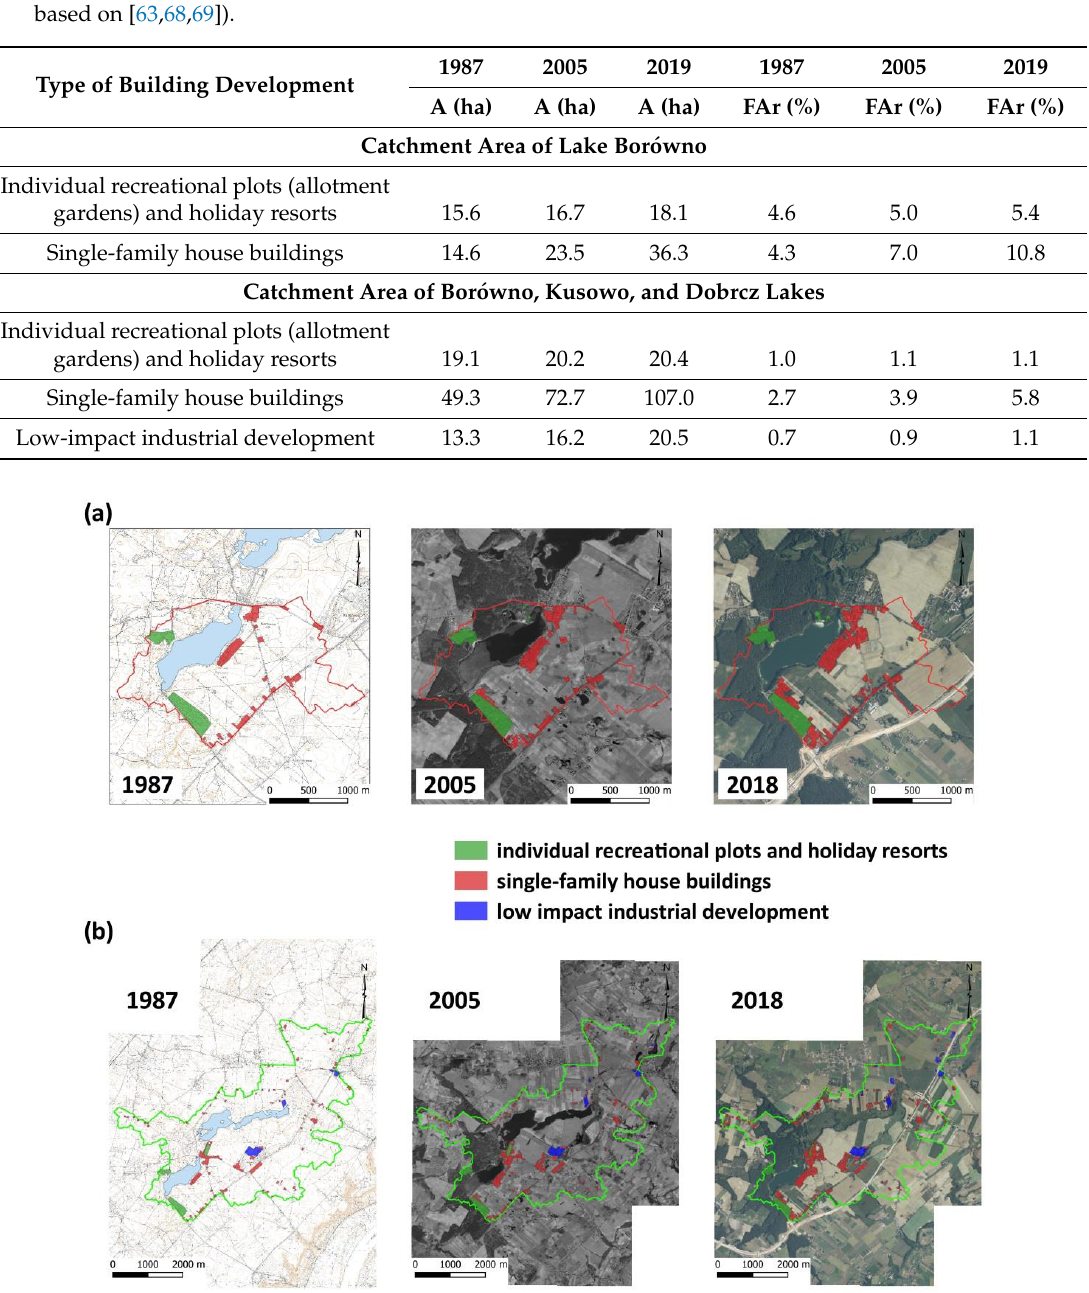
Figure 4. Changes in the building development area in: ( a ) the catchment of Lake Borówno, and ( b ) the catchment of Lakes Borówno, Kusowo, and Dobrcz (prepared based on [63,68,69]). Data presented in Figure 3a show an increase in water consumption from 1985 to the